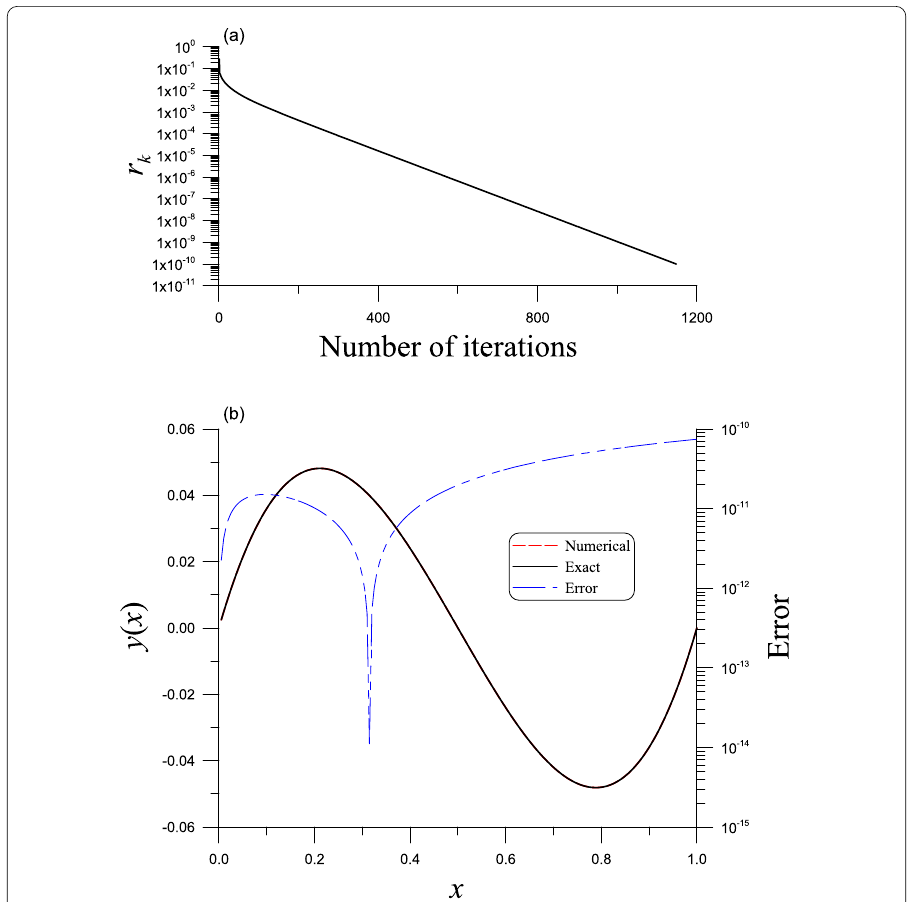
Figure 4 For Example 3 of a nonlinear three-point BVP solved by the BSFM, ( a ) showing convergence behavior and ( b ) comparing numerical and exact solutions and showing numerical error